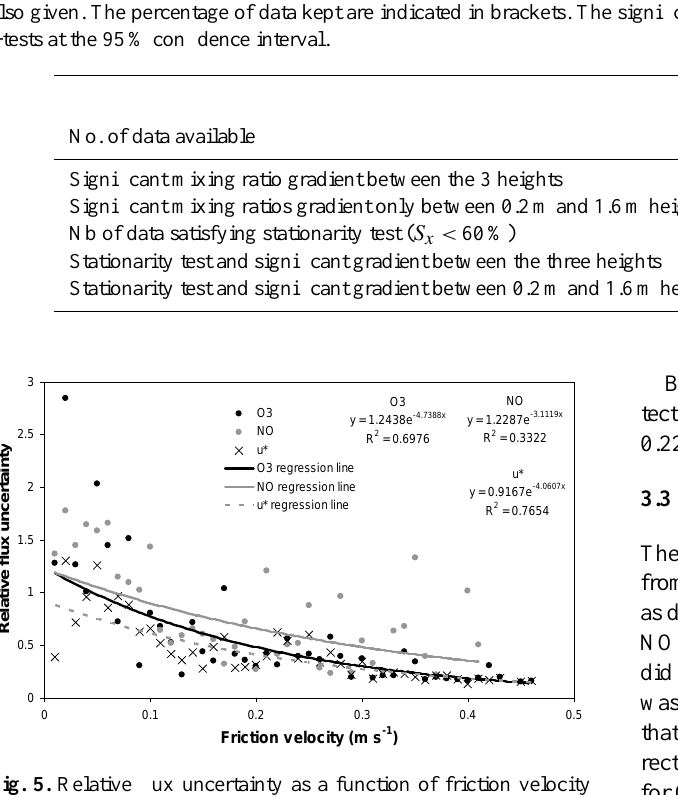
Fig. 5. Relative flux uncertainty as a function of friction velocity for O 3 (black circles), NO (grey circles), and u ∗ (crosses). Black line, grey line and dotted line are regressions for O 3 , NO and u ∗ , respectively. The size of the bins used for averaging is 0.01 m s -1 . Only data satisfying both stationarity test and having mixing ratio gradients between the three levels above the detection limit were used. Since NO 2 failed both tests it is not represented here.